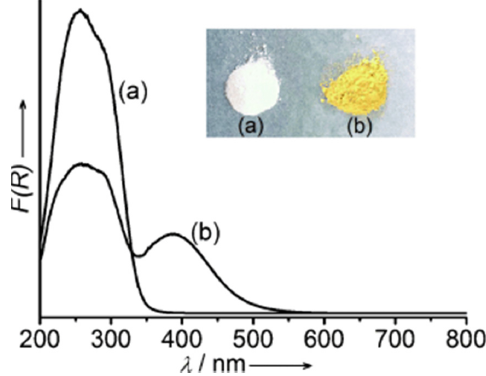
Figure 5. UV ‐ Vis spectra of ( a ) MIL ‐ 125(Ti) and ( b ) NH 2 ‐ MIL ‐ 125 (Ti). The inset shows the samples. Figure 5. UV-Vis spectra of ( a ) MIL-125(Ti) and ( b ) NH 2 -MIL-125 (Ti). The inset shows the samples. Reproduced with permission from [108]. Copyright 2012, Wiley ‐ VCH. Reproduced with permission from [108]. Copyright 2012,